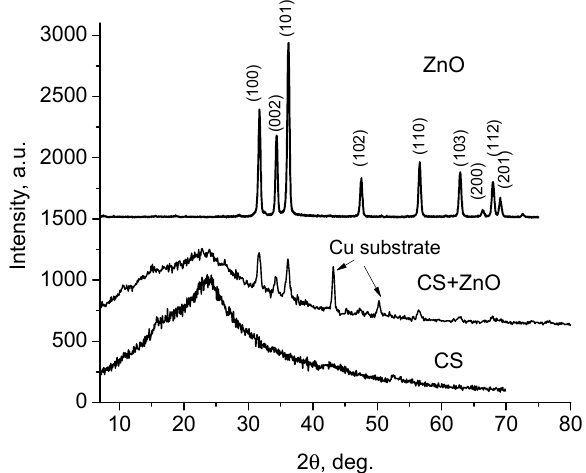
Figure 1. X-ray di ff raction patterns of neat chitosan (CS) film, CS ZnO NPs composite, and ZnO nanoparticles (NPs).